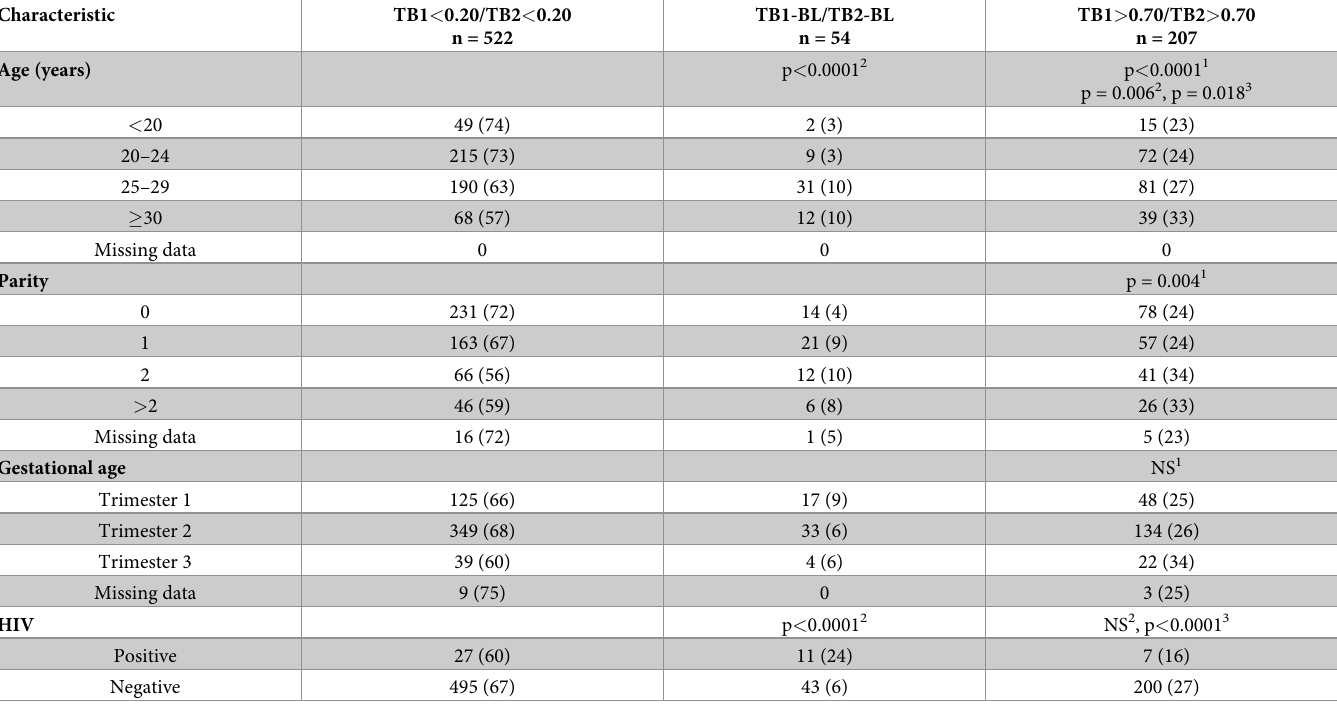
Due to the lack of gold standard for LTBI, the optimal cut-off cannot be precisely deter- mined and may be influenced by immune status and likelihood of TB exposure. Therefore, we wanted to explore the borders of the borderline interval as potential alternative cut-off values depending on the setting. Using the upper limit of the borderline zone for defining a positive